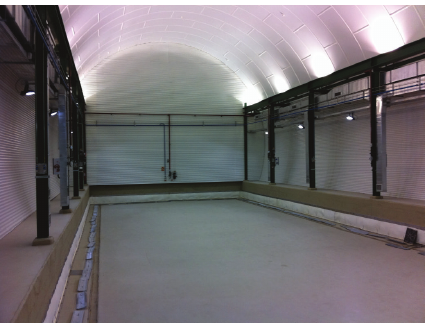
Figure 19: View of Hall A of the Laboratorio Subterr´aneo de Canfranc prior to any equipment